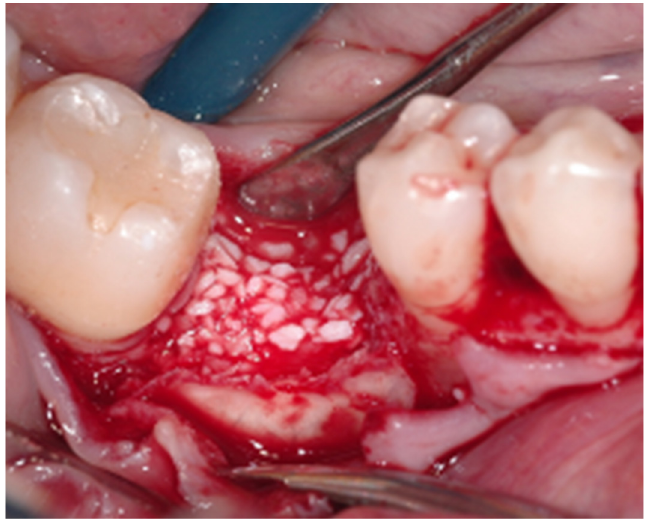
Figure 1. Creation of the containing “box” using a heterologous cortical lamina.